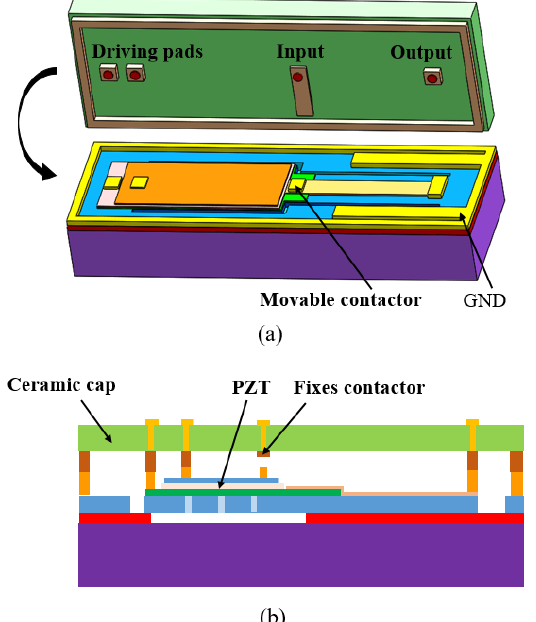
Figure 10. A compact piezoelectric-actuated MEMS switch (Nakatani et al. 2013 [130]): ( a ) the schematic view; ( b ) the photo of the fabricated switch.